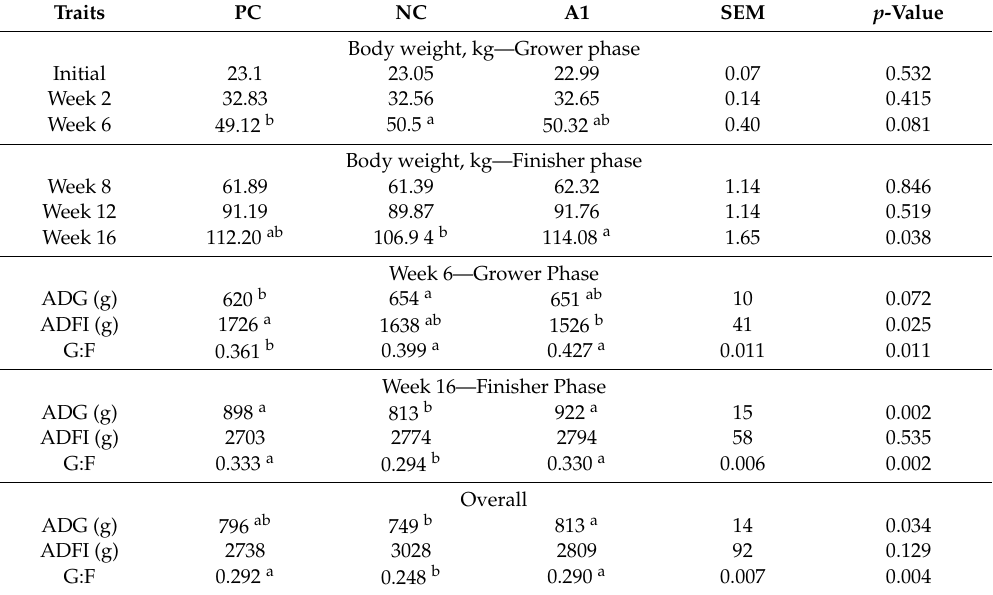
Table 2. E ff ects of dietary supplementation of enzyme blends on growth performance traits in grower–finisher pigs.